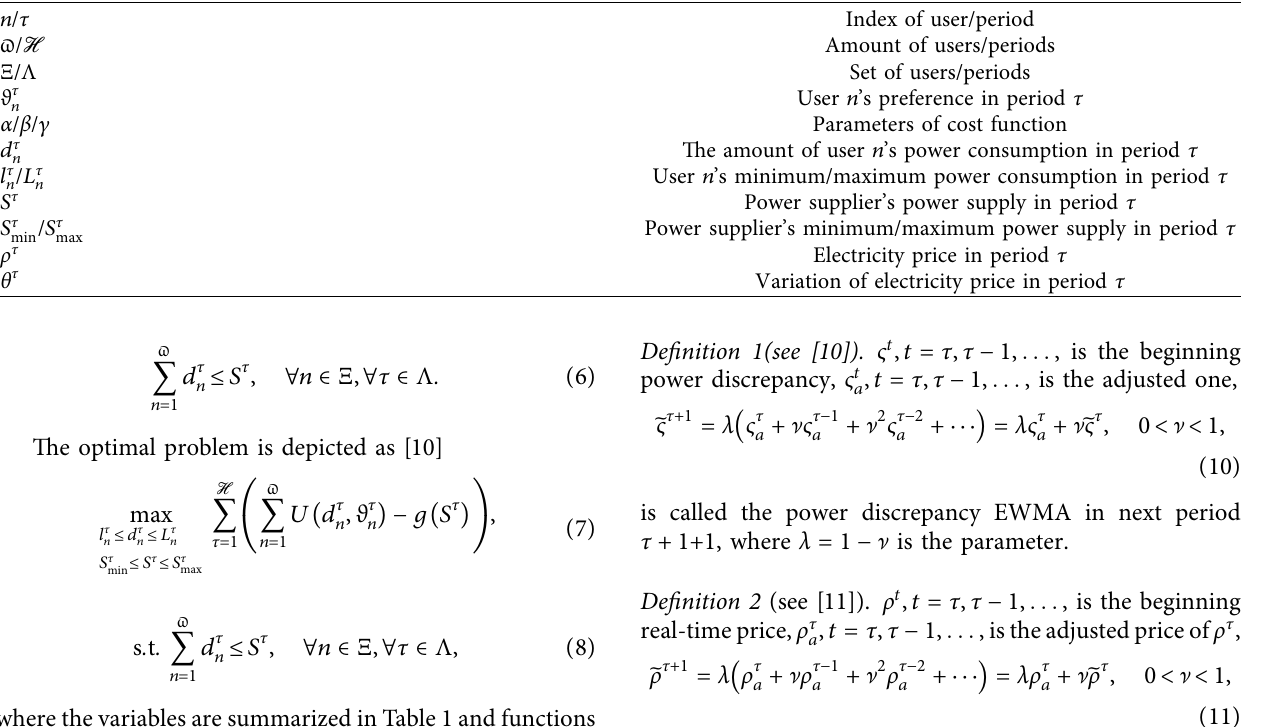
Table 1: List of notations and